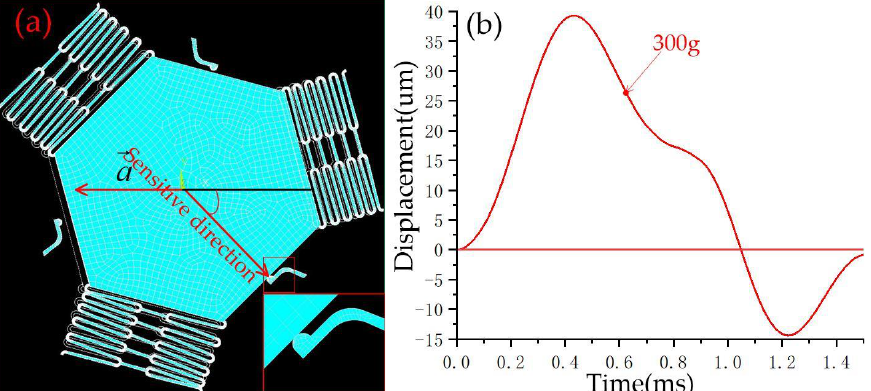
Figure 8. ( a ) Schematic diagram of a movable electrode in contact with a fixed electrode in the directions away from the sensitive direction of 45°, ( b ) the dynamic contact process curves of movable and fixed electrodes in the directions away from the sensitive direction of 45°.